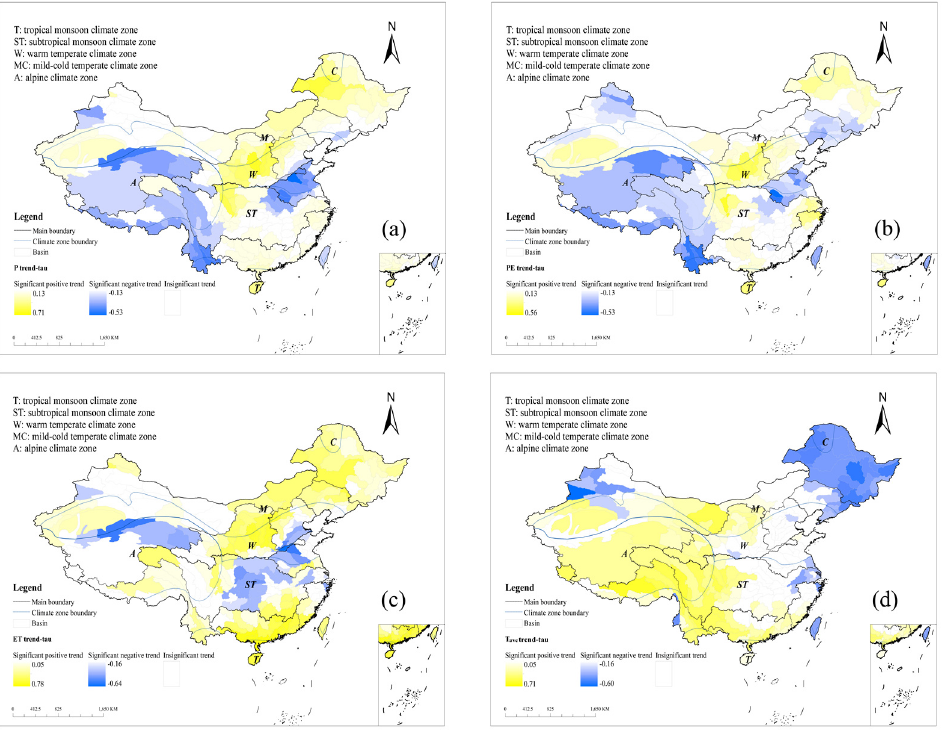
16 of 26 Figure A2. The spatial distributions of long-term ( a ) LAI; ( b ) NDVI ; ( c ) VFC ; and ( d ) SM. Appendix B According to Figure A3a, significant increments ( p < 0.05) in precipitation ( P ) are mainly detected in tropical, central warm temperate (particularly the Loess Plateau), and eastern mild-cold temperate watersheds, while significant decrements ( p < 0.05) are found in watersheds located in alpine and eastern warm temperate climate zones. Effective pre- cipitation ( PE ) significantly increases in warm temperate watersheds, whereas it signifi- cantly decreases in alpine and southwestern subtropical watersheds (Figure A3b). For sig-